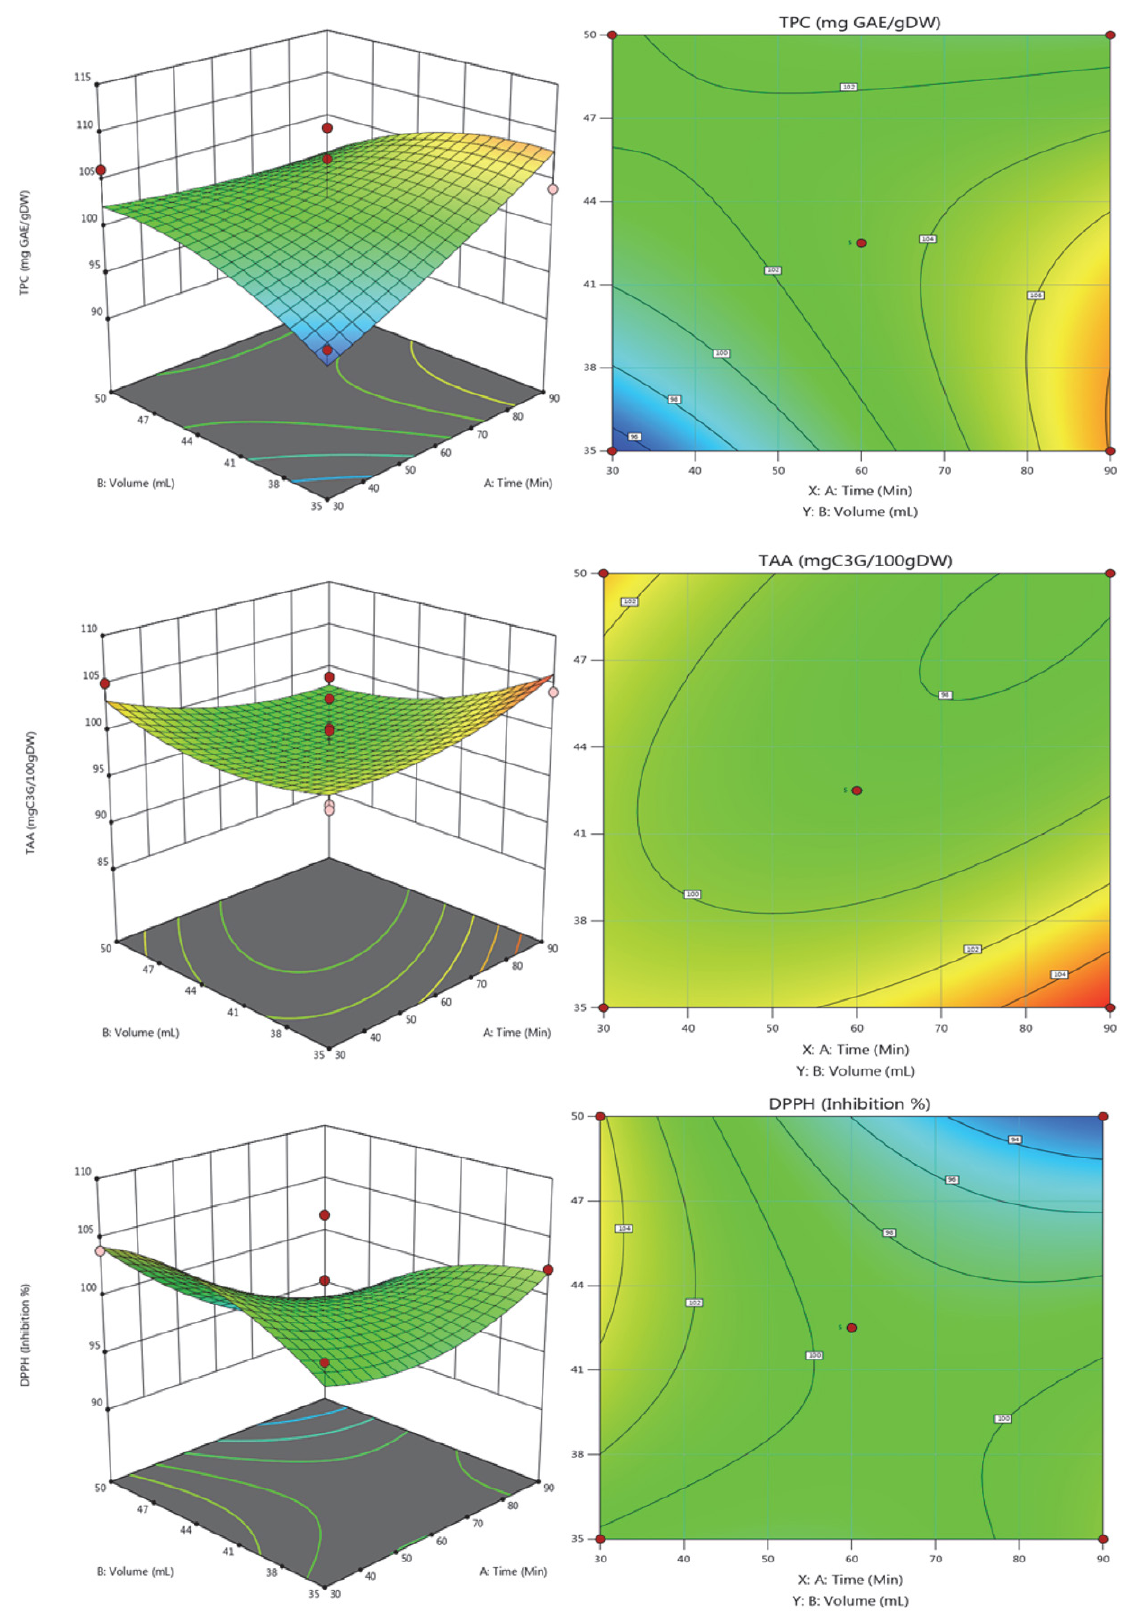
Figure 3. A 2D contour plots and 3D response surface of TPC, TAA, and DPPH as a function of time (min) and solvent volume